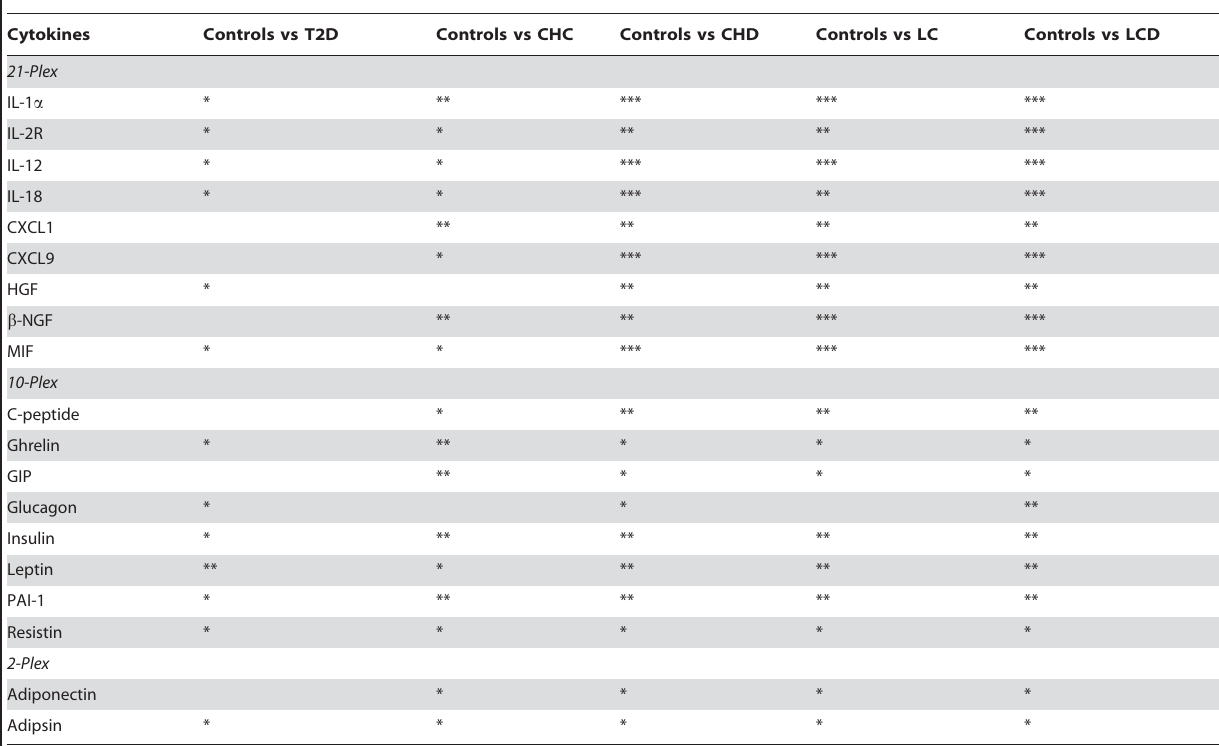
Table 2. Comparison of cytokine serum levels in all patients and healthy controls.